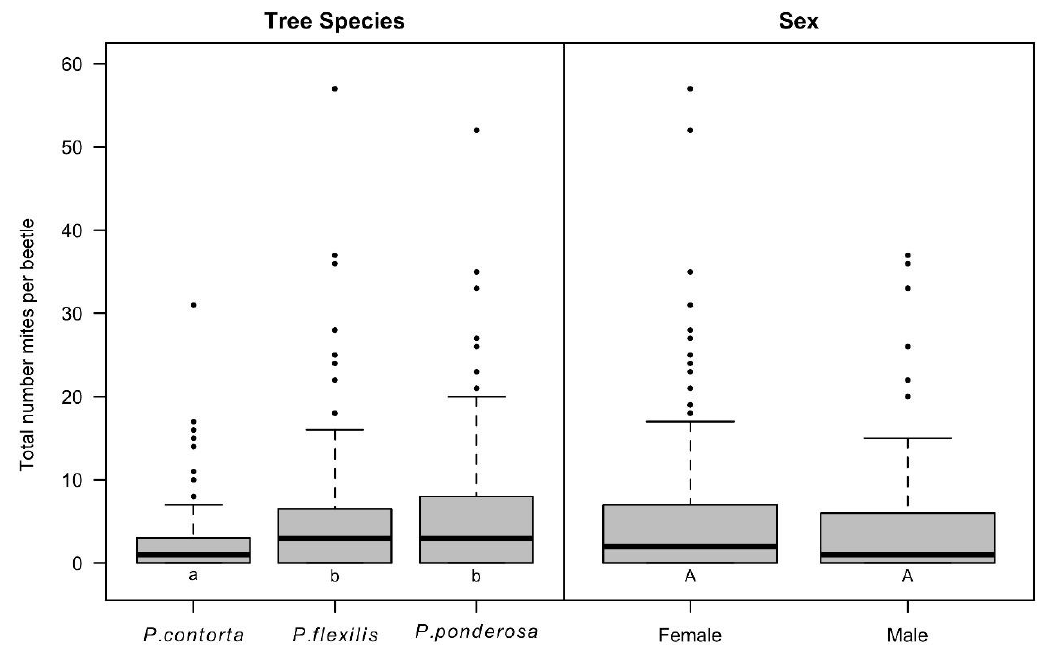
Figure 3. The boxplots of MPB phoretic mite trends within beetles attacking three pine hosts (left panel) and within beetle sexes (right panel) in 2013. The total number of mites per beetle was lower in MPBs attacking P. contorta , but was not substantially different between male and female MPBs. Differences among groups are identified by the letter under each boxplot within a panel using a significant level of 0.05.